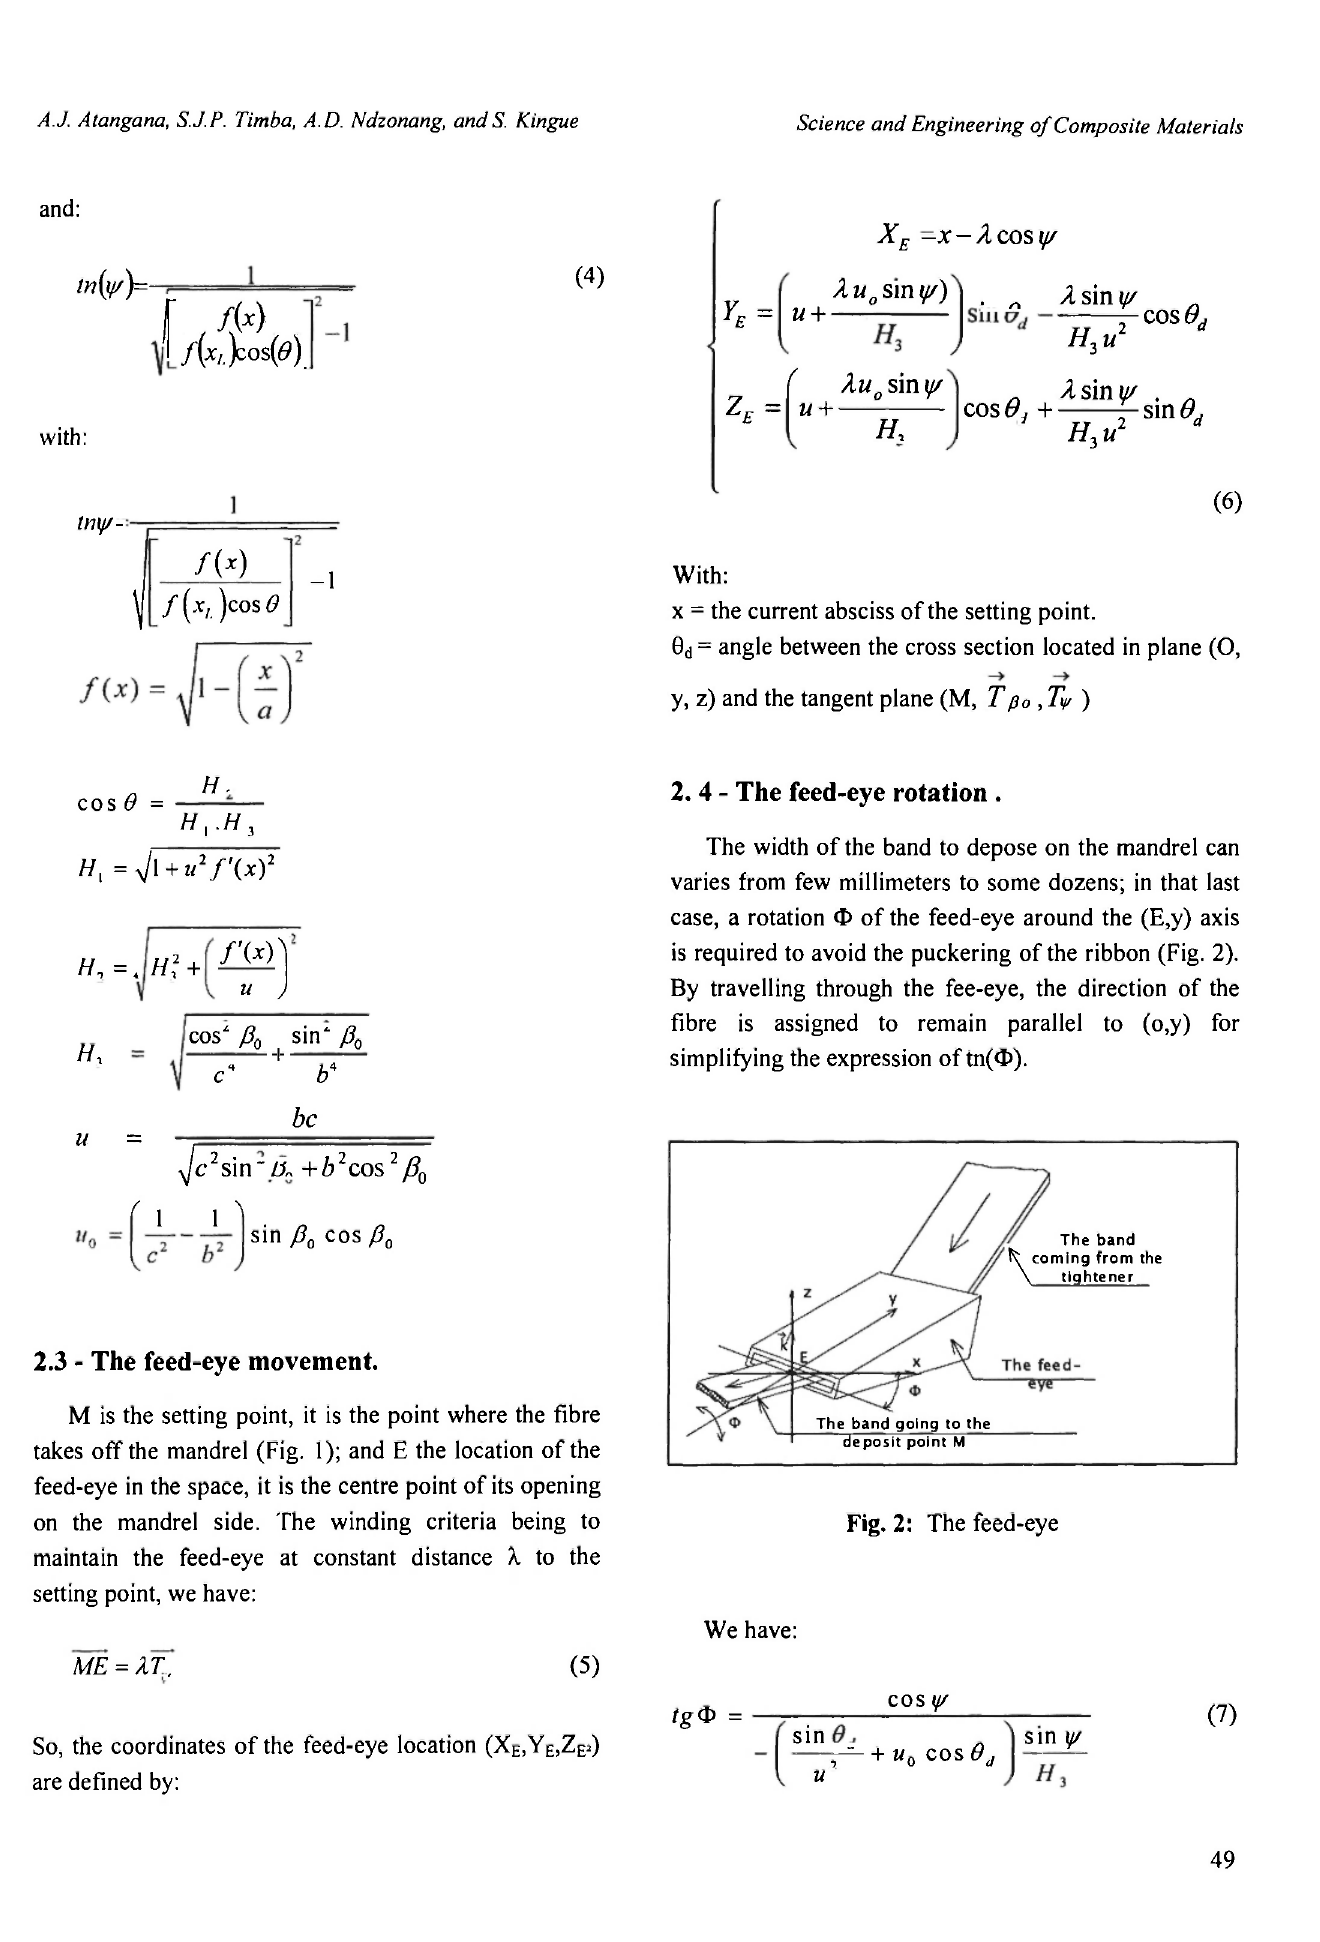
2. 4 - The feed-eye rotation .